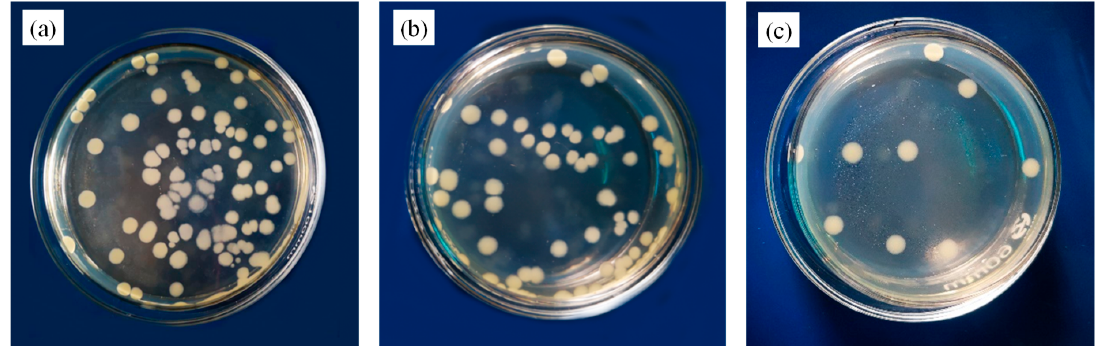
Figure 13. Images showing mCu ‐ Zn/PWF/PLA composites against E. coli : ( a ) Pure PLA; ( b ) PLA ‐ 5PWF; ( c ) PLA ‐ 2mCu ‐ Zn.